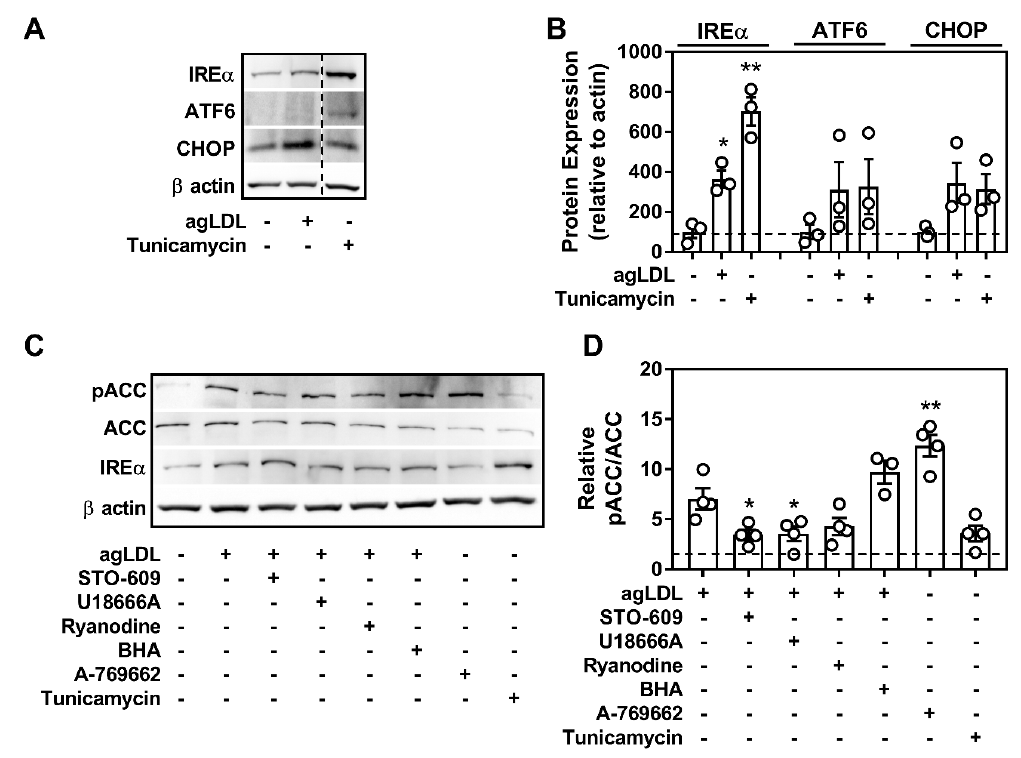
Figure 2. Aggregated (agLDL) induces endoplasmic reticulum (ER) stress and activates AMPK partially through calmodulin-dependent protein kinase kinase-2 (CaMKK2) signaling in cultured macrophages. ( A ) Representative immunoblots depicting the induction of ER stress by upregulation of its markers IRE α (130 kDa), ATF6 (90 kDa), and CHOP (27 kDa) in response to agLDL (50 µ g / mL). Dashed line in A signifies where the image was cropped but represents the same gel. ( B ) Relative quantification of ER stress markers relative to β actin. ( C ) Assessing the potential role that CaMKK2 (STO-609; 25 µ M), cholesterol tra ffi cking (U18666A; 1 µ M), ER-calcium release (Ryanodine; 1 µ M), and ROS (BHA; 100 µ M) play a role in activating macrophage AMPK in response to agLDL (50 µ g / mL). ( D ) Relative quantification of pACC to ACC signal, shown relative to the vehicle control treated (no agLDL) cells (dashed line). Macrophages isolated from WT mice were incubated with agLDL (50 µ g / mL) along with inhibitors for 18 h. A-769662 (100 µ M) and Tunicamycin (2.5 µ g / mL) were used as a positive control for AMPK activation and ER stress, respectively. pACC / ACC (260 kDa) and β actin (37 kDa). Data are the mean ± SEM and are representative of at least three independent experiments using macrophages isolated from separate mice, where * and ** represent p < 0.05 and p < 0.01 compared to the vehicle control for ( A ) and compared to agLDL-treated cells in ( D ).